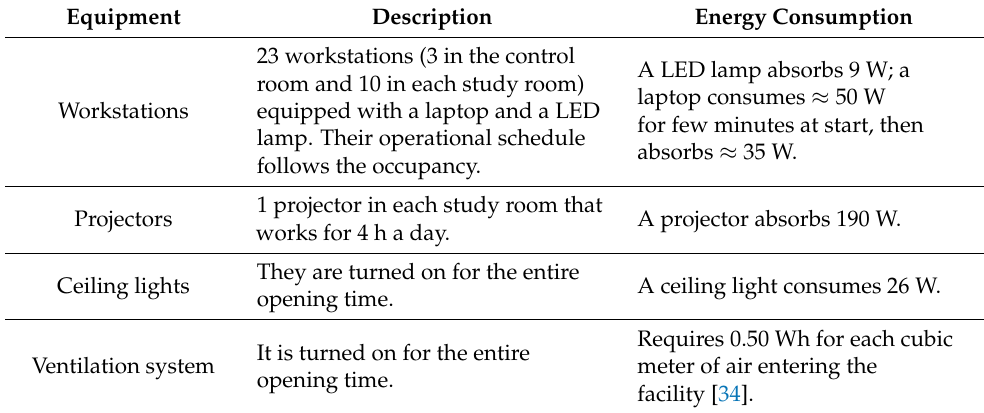
Table 5. Description of the facility